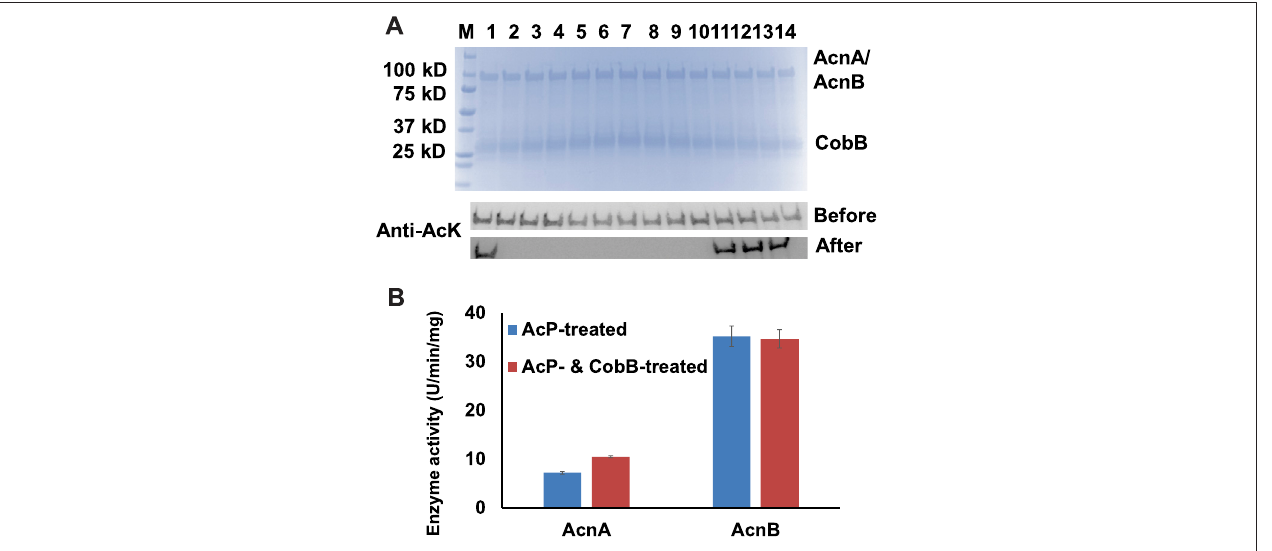
FIGURE 3 | CobB-catalyzed deacetylation of AcnA and AcnB. (A) SDS-PAGE and wester blots of site-speci fi cally acetylated AcnA and AcnB variants incubated withCobB in vitro . 2 µg ofAcnA/AcnB and CobB were loaded foreach lane.The fullimage ofwestern blotsisin Supplementary Figure S17 .Samplesfrom lane 1to4 are AcnA-164AcK, -342AcK, -482AcK, and -684AcK. Samples from lane 5 to 14 are AcnB-77AcK, 373-AcK, -396AcK, -407AcK, -539AcK, -559AcK, -567AcK, -728AcK, -759AcK, and -835AcK. (B) Enzyme activities of AcP-treated AcnA and AcnB before and after CobB-incubation. Mean values and standard deviations